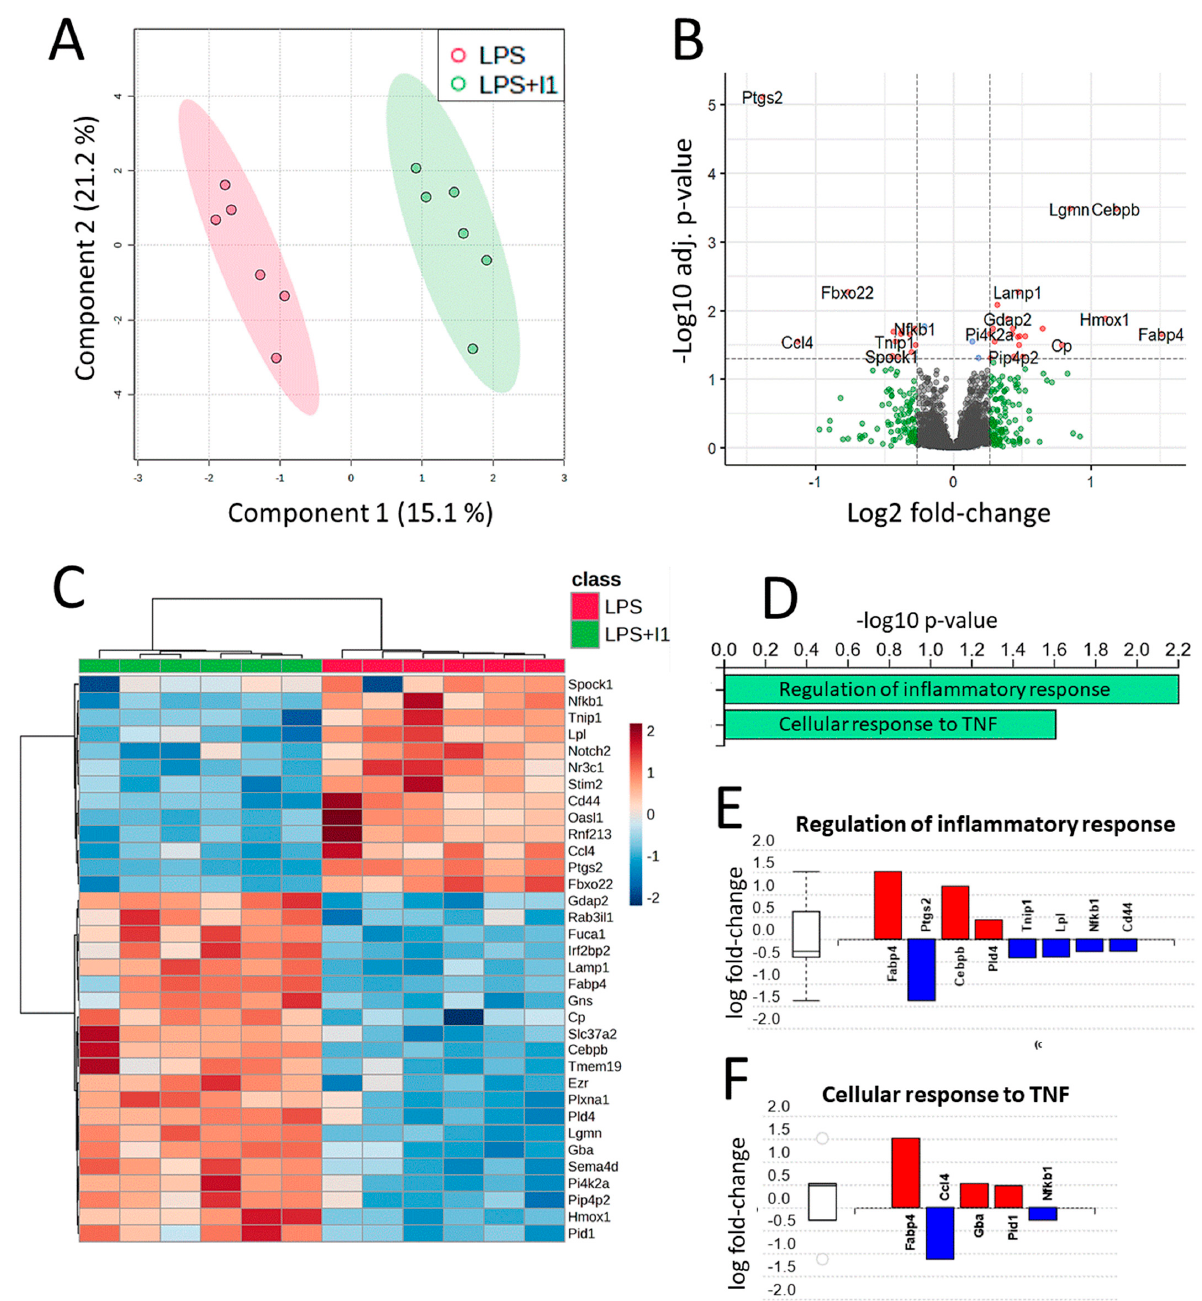
Figure 4. Overview of proteomic analysis results. ( A ) Partial least squares discriminant analysis (PLSDA) two-component score plot including all 6065 considered quantified proteins. Bioreplicates from both experimental groups are clearly separated. ( B ) Volcano plot showing proteins with differential expression in LPS-activated RAW 264.7 as a result of inulin treatment. Dotted lines show adjusted p -values < 0.05 and 1.2 fold-change cutoffs; proteins above both thresholds are shown in red. ( C ) Heatmap showing the unsupervised clustering of the 12 analyzed bioreplicates using the 34 proteins with differential expression as measured by diaPASEF LC-MS. Samples from the LPS + I1 and reference (LPS) groups are shown in green and red, respectively. ( D ) GO analysis showing significant (adjusted p -values < 0.05) biological processes. Gene perturbation bar plots for the affected proteins within biological processes, ( E ) regulation of inflammatory response, and ( F ) cellular response to tumor necrosis factor (TNF). Overexpressed proteins are shown in red, and under-expressed proteins are shown in